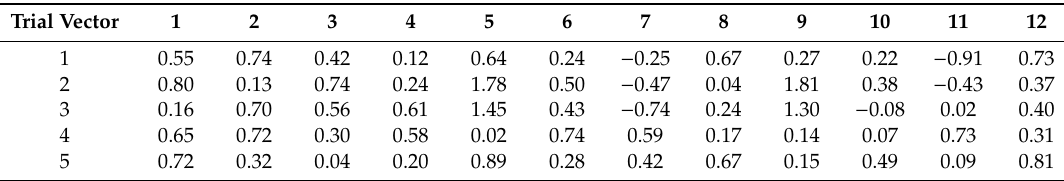
Table 8. Trial vectors from round 1.